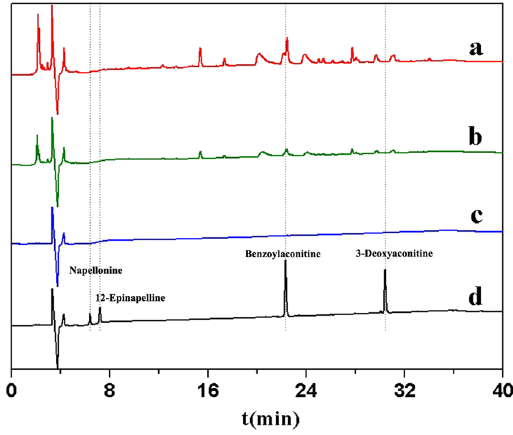
Figure 5. Chromatograms of the extracts from ASG using FGFR4/CMCSPs SPE-HPLC/MS. Initial solutions before FGFR4/CMCSPs SPE ( a ), solution after loading ( b ), solution after washing ( c ) and solution after eluting ( d